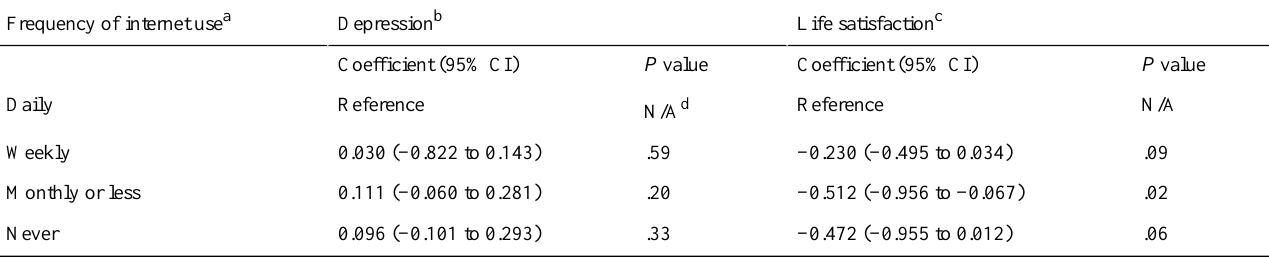
Table 2. Fixed effects model coefficients for frequency of internet use on mental health